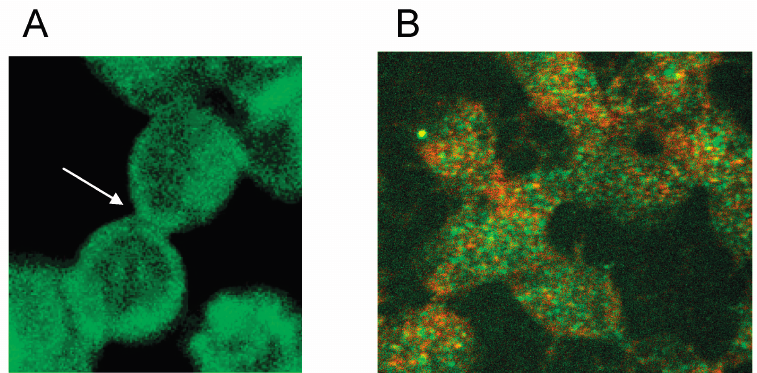
Figure 6. Spectrin reorganization in aggregated erythrocytes suspended in autologous plasma (reprinted from reference [20], Copyright 2013, with permission from IOS Press) ( A ) spectrin-stained erythrocytes; ( B ) Merger of red and green channels of the confocal microscope of spectrin–actin double stained erythrocytes. (Primary magnification 1:63; zoom factor